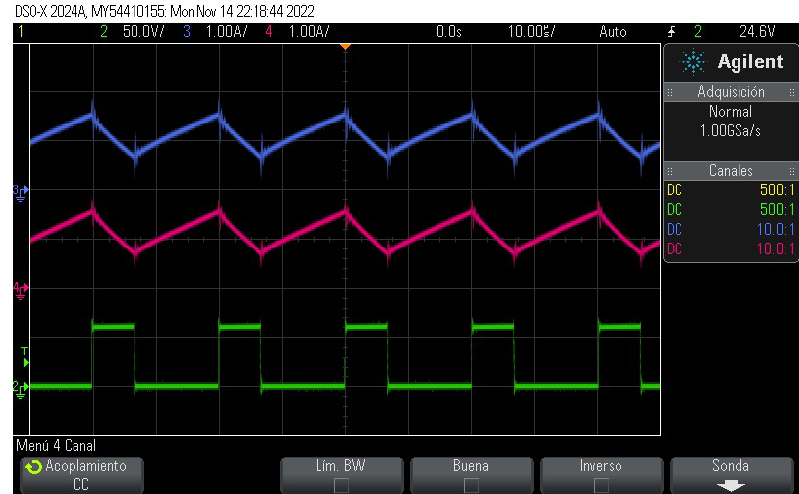
Figure 18. From the top to the bottom: inductor current i L 1 (blue trace), inductor current i L 2 (pink trace), and terminal voltage of transistor ¯ s 1 = 60 V (green trace) of